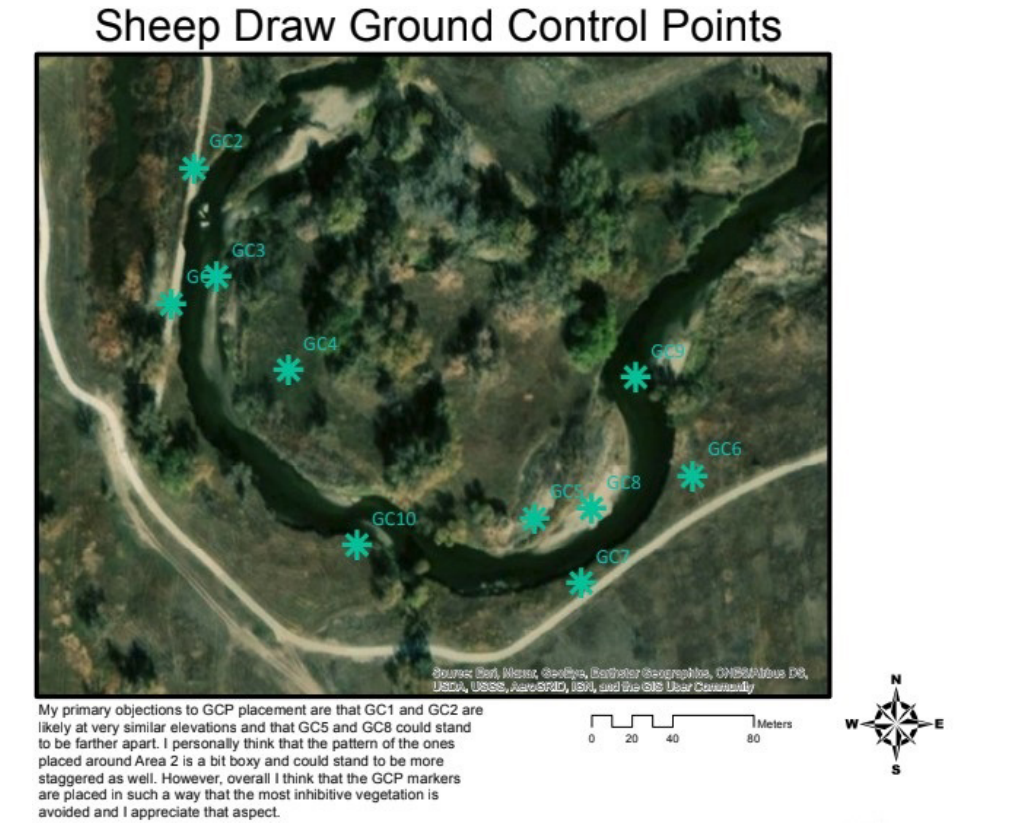
Figure 5. Student map of ground control points (GCPs) used in SfM activity (created by student in course; student name not disclosed to comply with Institutional Review Board). Through a group discussion on Day 2, students discussed whether GCPs were adequately placed and suggested implementation improvements. Imagery source: ArcGIS ® software by